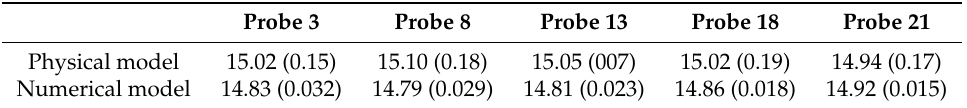
Table 2. Comparison between mean pressures computed in the physical and in the numerical model in the dissipation tank at discharge flow rate of 300 m 3 /s. Corresponding standard deviations are displayed in brackets. Pressures are in meters of water column.